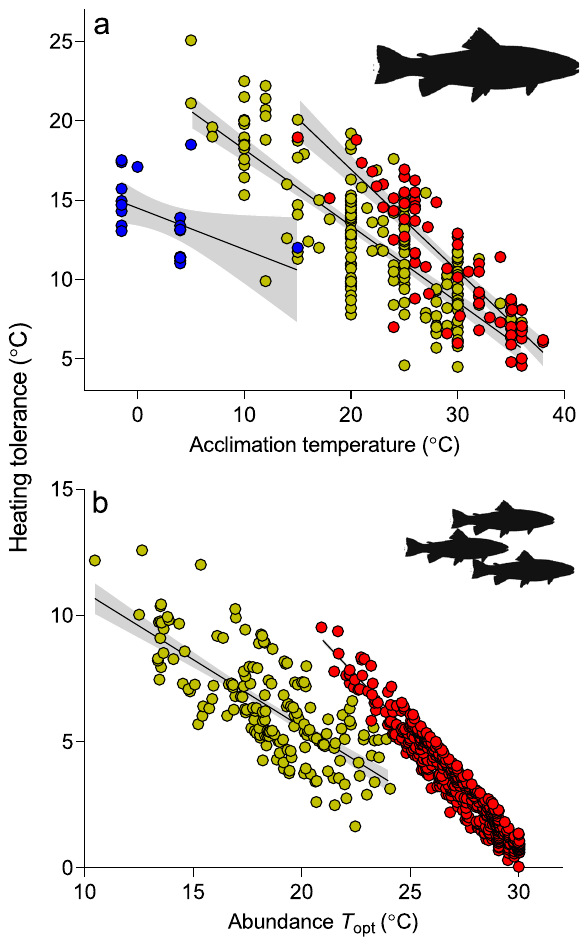
Fig. 2 Fish heating tolerances at different biological scales. a At the individual level, physiological heating tolerance is CT max − T a , and b at the population level, population heating tolerance is T lim − T opt (as per Fig. 1). Tropical, temperate and polar species are indicated by red, yellow and blue, respectively. For panel a , each symbol represents a mean measurement ( n = 269) from 121 different species, and for b , each symbol represents a different species ( n = 702). Lines represent regression mean and 95%